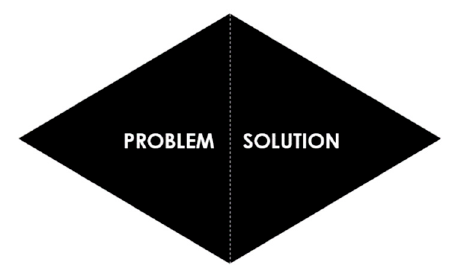
Figure 4. Problem-Solving Exercise Formulation Scheme (authors).